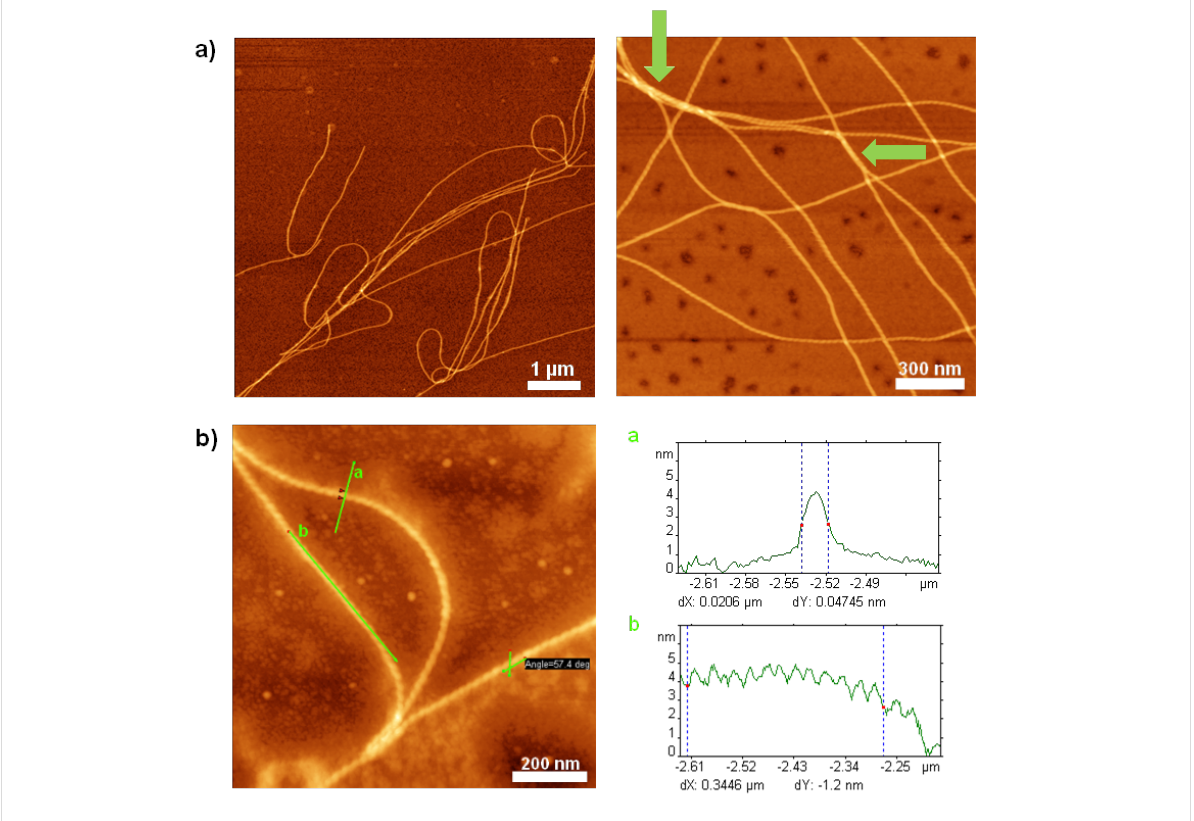
Figure 6: AFM height images of 6' on mica from a 1:1 DCM/MeOH solution. a) left: Image of fibers obtained after 2 d; right: Zoom of fiber networks; green arrows: Contact points of individual fibers; b) left: Zoom of left-handed helical fibers; right: Cross section and height profile of helical fiber [22].